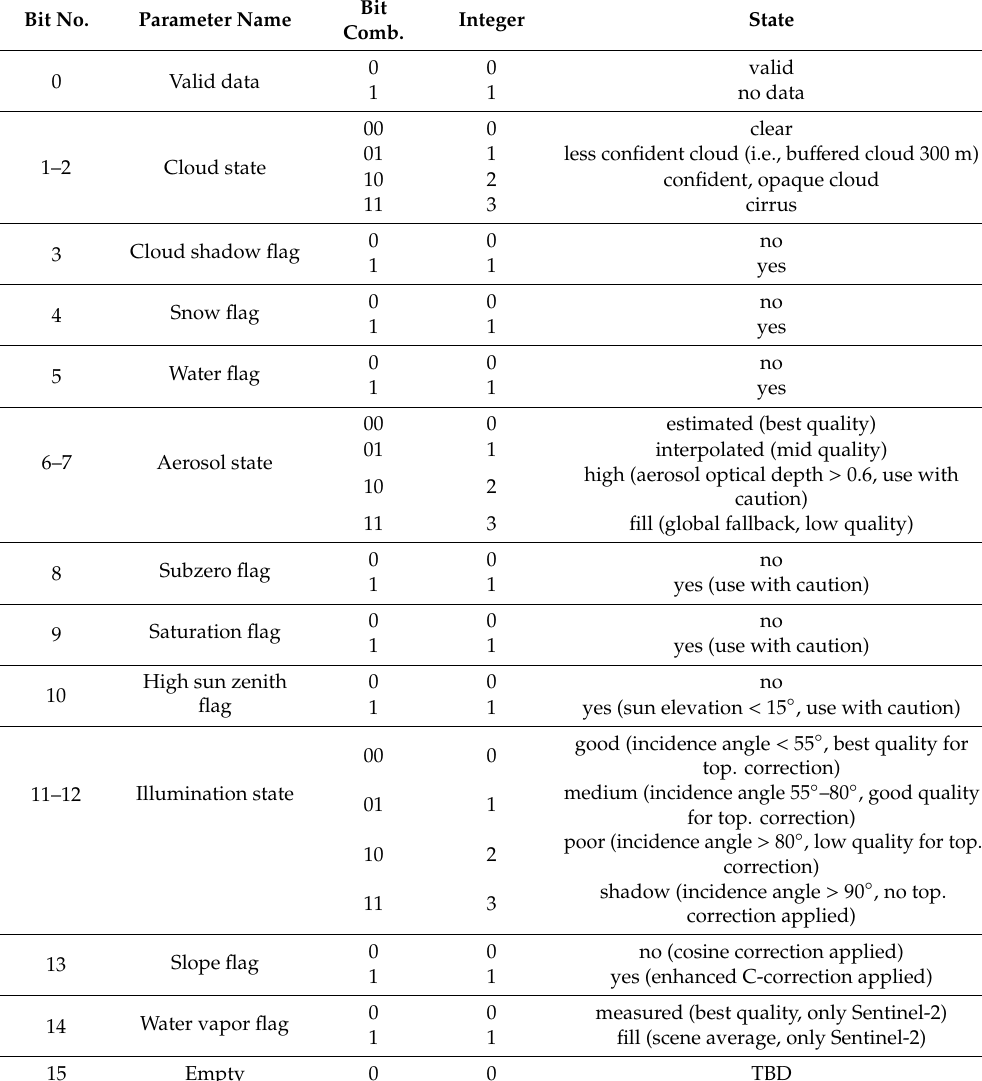
Table 2. Quality assurance information (QAI)